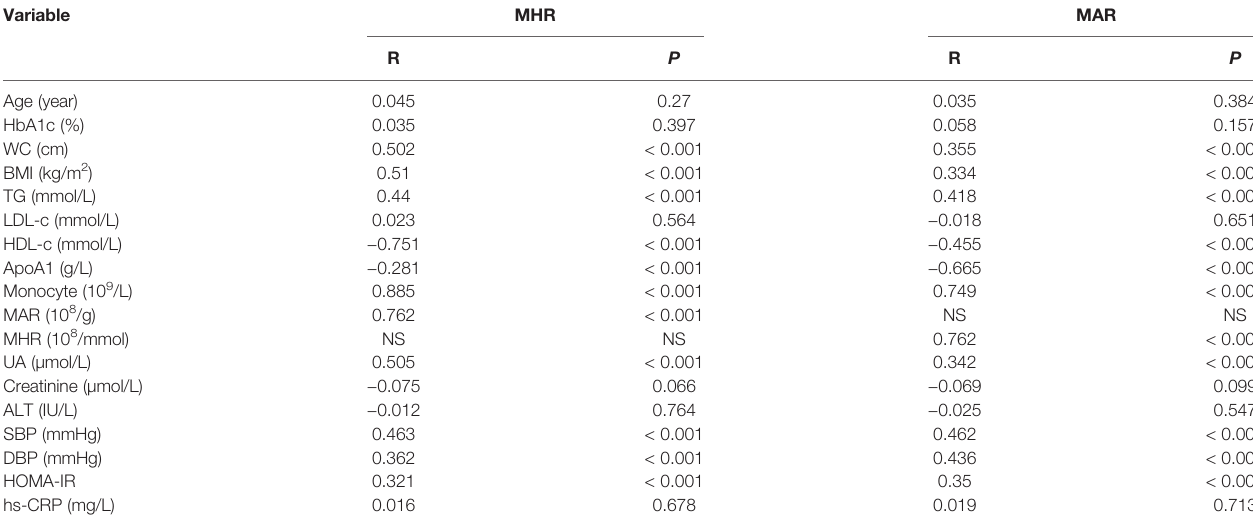
TABLE 4 | Correlations between MHR, MAR and metabolic parameters.